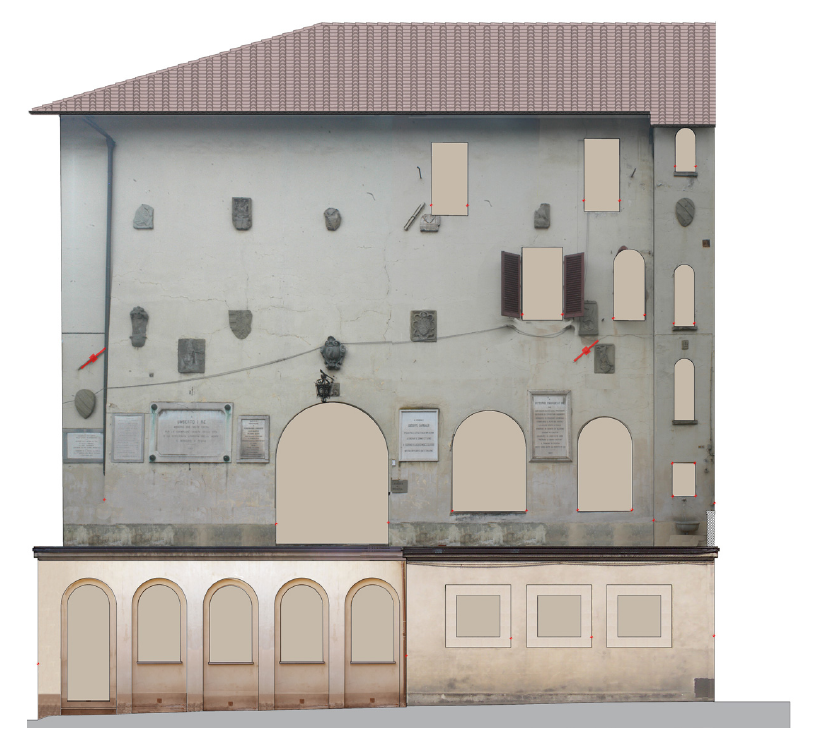
Figure 6. View of the Eastern